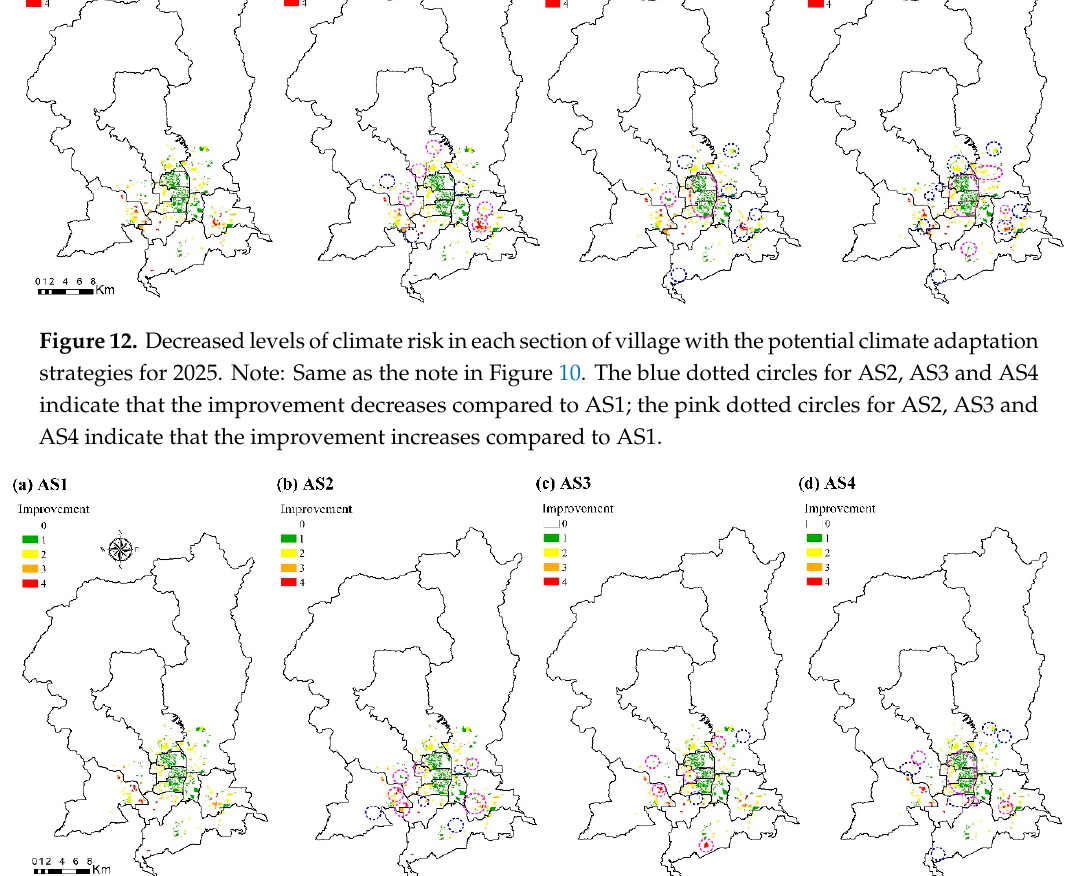
Figure 13. Decreased levels of climate risk in each section of village with the potential climate adaptation strategies for 2030. Note: Same as the note in Figure 10. The blue dotted circles for AS2, AS3 and AS4 indicate that the improvement decreases compared to AS1; the pink dotted circles for AS2, AS3 and AS4 indicate that the improvement increases compared to AS1.